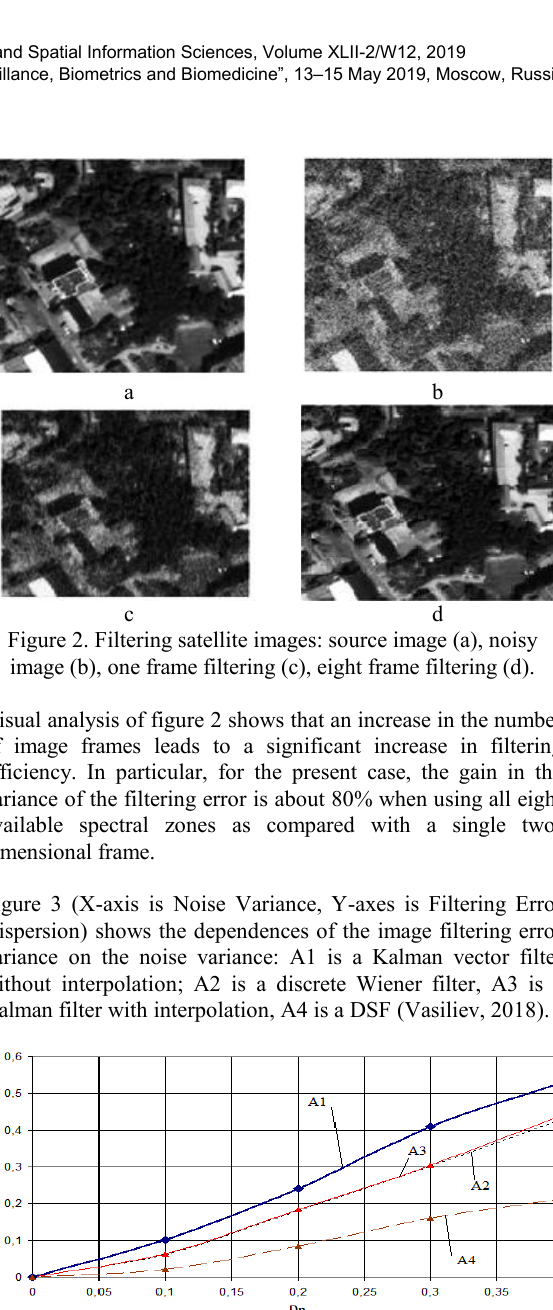
Figure 3. Filtration efficiency during satellite images